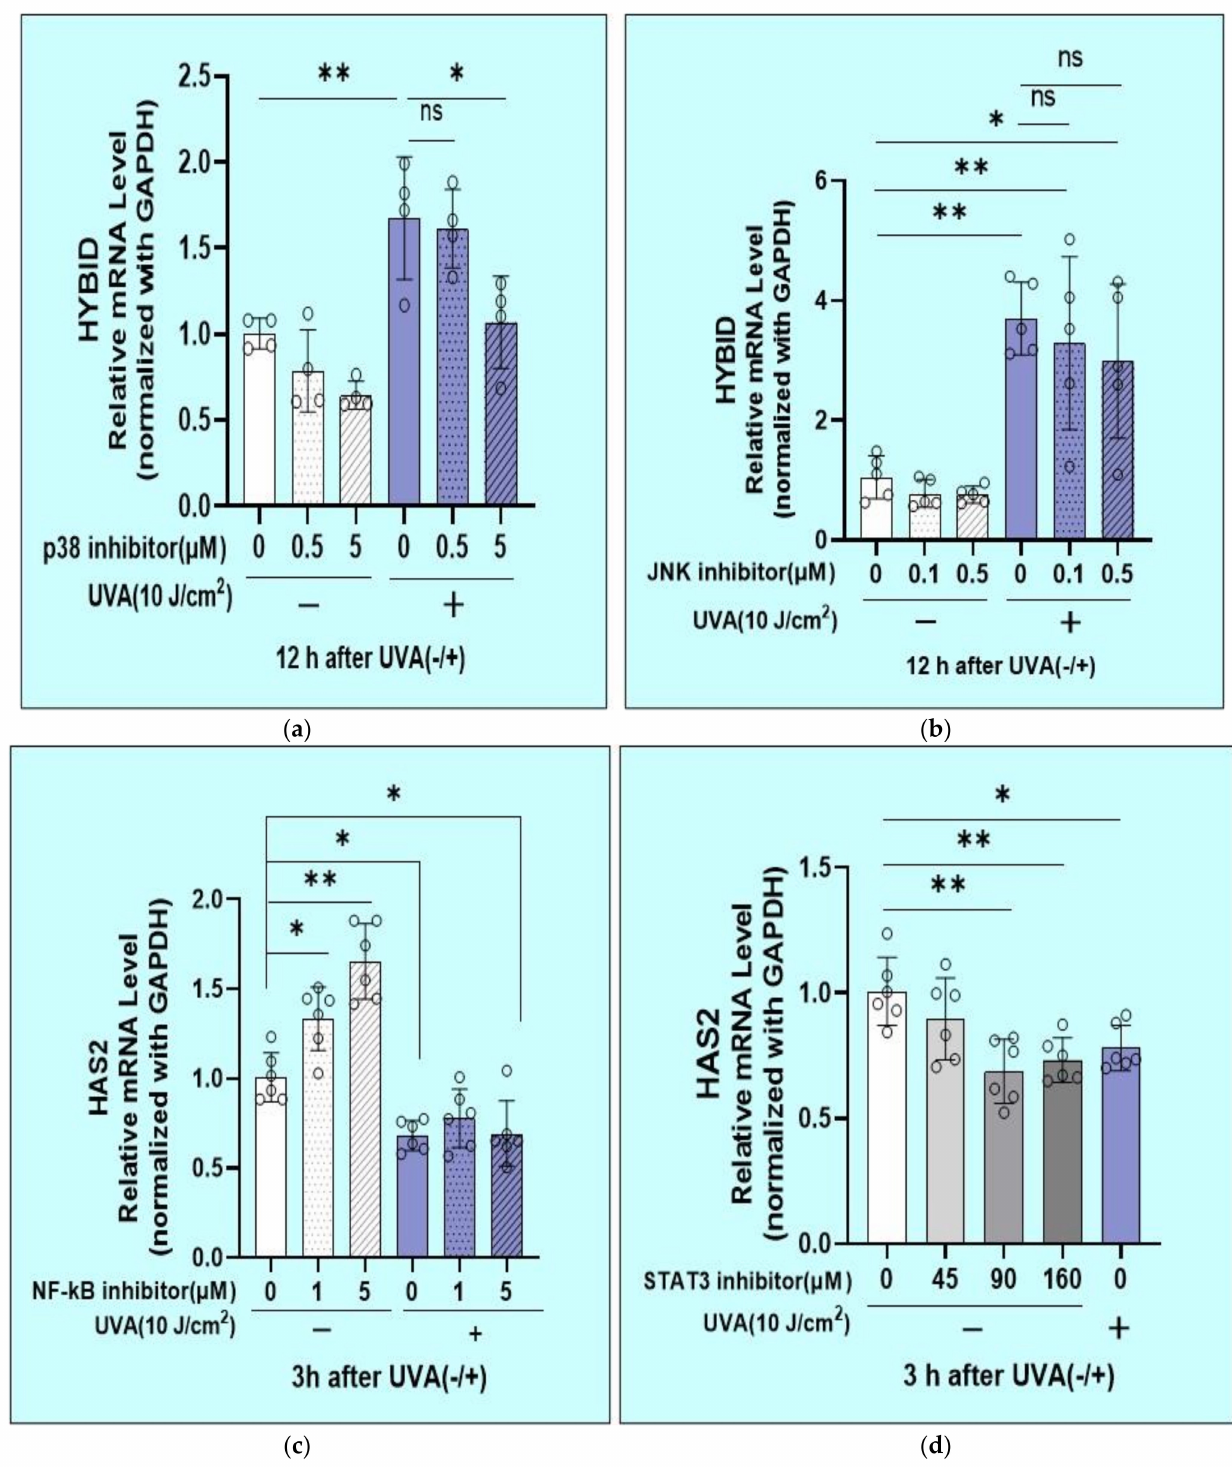
Figure 14. Effects of signaling inhibitors on mRNA expression levels of HAS2 and HYBID in HDFs. Effects of inhibitors of p38, JNK, NF-kB, and STAT3 on UVA- or sham-stimulated mRNA expression of HAS2 in HDFs. Signaling inhibitors were added at the indicated concentrations immediately after UVA irradiation at 10 J/cm 2 or sham irradiation. Cell lysates prepared at the indicated times post-irradiation were subjected to RT-qPCR analysis. ( a ) p38 inhibitor, 12 h, n =